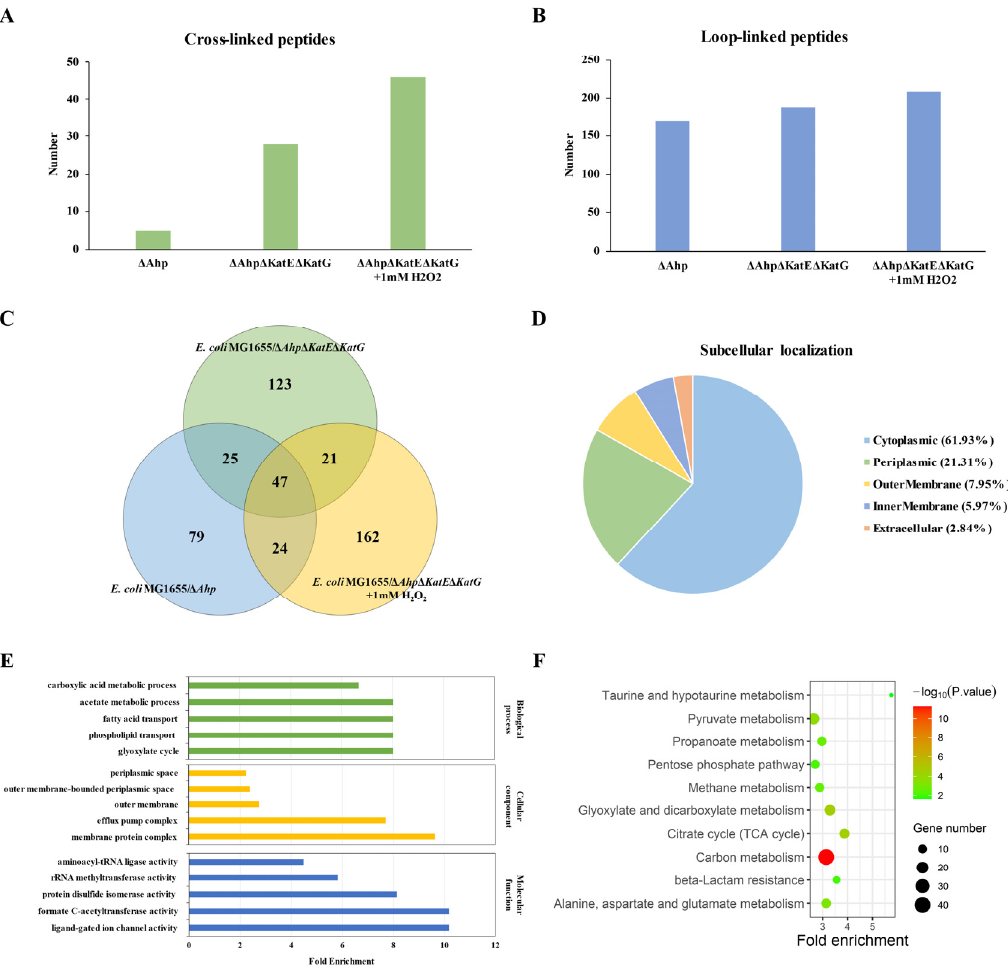
Figure 2. Bioinformatic analysis for qualitative data of dityrosine-linked peptides. The number of dityrosine crosslinked peptides ( A ) and -loop linked peptides ( B ) identified by pLink in the three groups ( E. coli MG1655/ ∆ Ahp , E. coli MG1655/ ∆ Ahp ∆ KatE ∆ KatG, and E. coli MG1655/ ∆ Ahp ∆ KatE ∆ KatG supplemented with 1 mM H 2 O 2 ). ( C ) Venn diagram of dityrosine-linked peptides for the three groups. ( D ) Subcellular localization of the proteins which corresponded to all the dityrosine-linked peptides identified by pLink in the three groups. ( E ) Gene ontology (TOP5 of fold enrichment for biological process, cellular component, and molecular function) analysis for all these proteins. ( F ) The TOP 10 enriched KEGG pathways for all these proteins along with p -value and gene number. The color represents the significance of